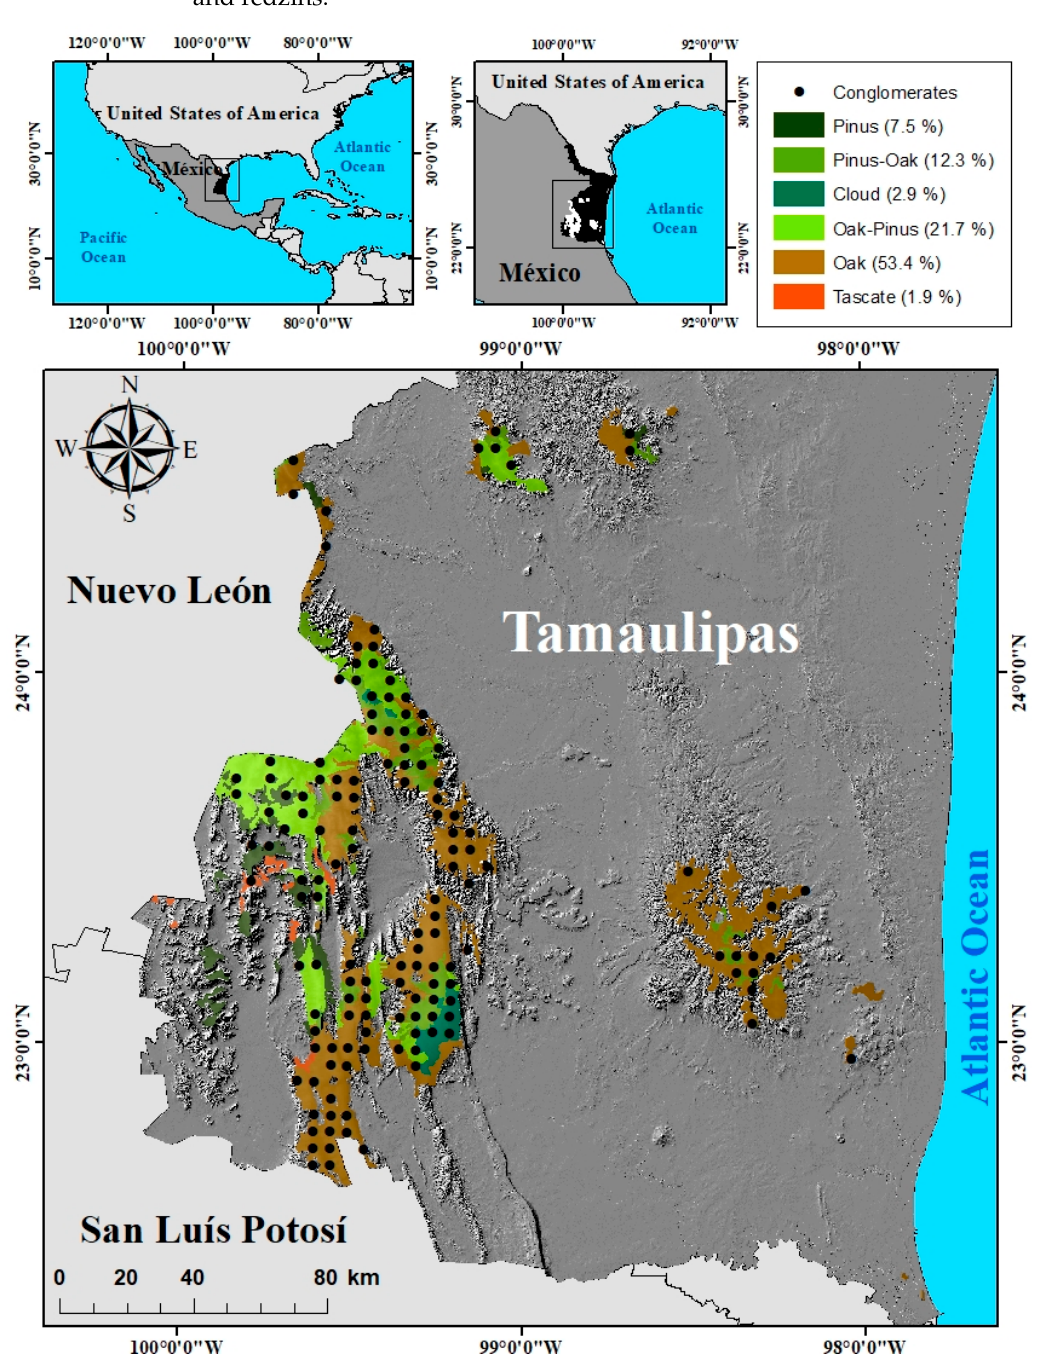
Figure 1. Location of the study area and conglomerates used to estimate fuel load in SE, central and coastal Gulf of Mexico, Tamaulipas, Mexico. coastal Gulf of Mexico, Tamaulipas,